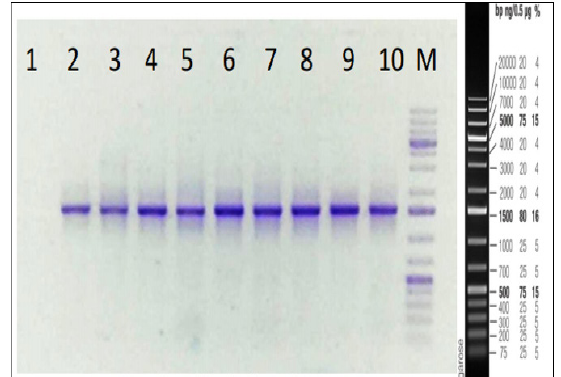
Figure 3 Amplifications of ribosomal DNA regions with primers 27F and 1492R. (1) White sequence (2. Sot 1, 3. Sot 2, 4. Sot3, 5. Sot4, 6. Sot5, 7. Sot6, 8. Sot7, 9. Sot8,